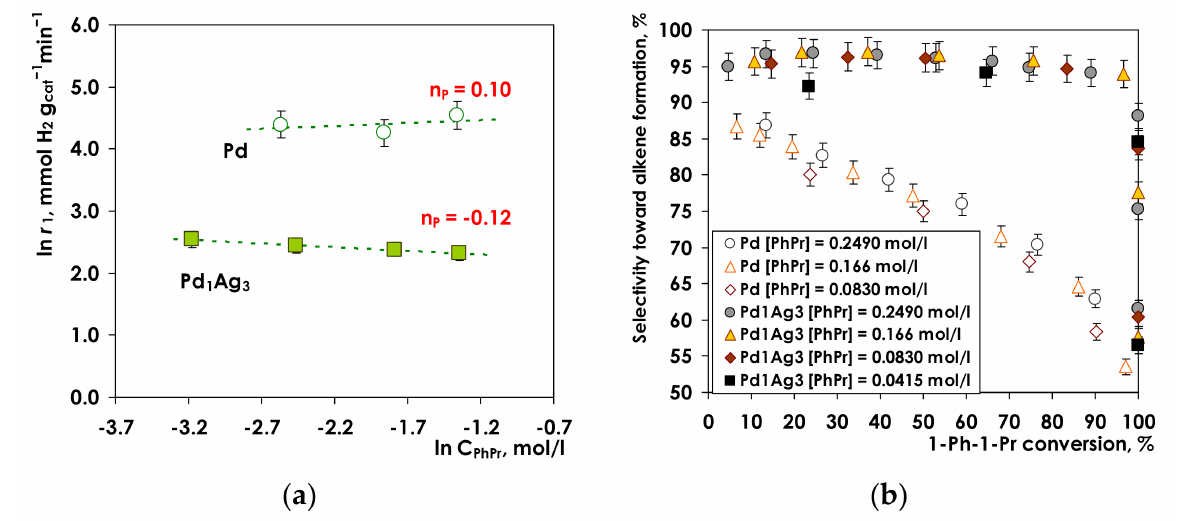
Figure 7. Hydrogenation of 1-Ph-1-Pr over Pd and Pd 1 Ag 3 : ( a ) Reaction rate vs. the initial 1-Ph-1-Pr concentration; ( b ) Selectivity toward propenylbenzene vs. 1-Ph-1-Pr conversion for various initial 1-Ph-1-Pr concentrations. Conditions: T= 25 ◦ C P(H 2 ) = 5 bar, m(Pd) = 1.5 mg, m(Pd 1 Ag 3 ) = 7.5 mg, V C6H14 = 6 mL. The error bars are ± 1 standard